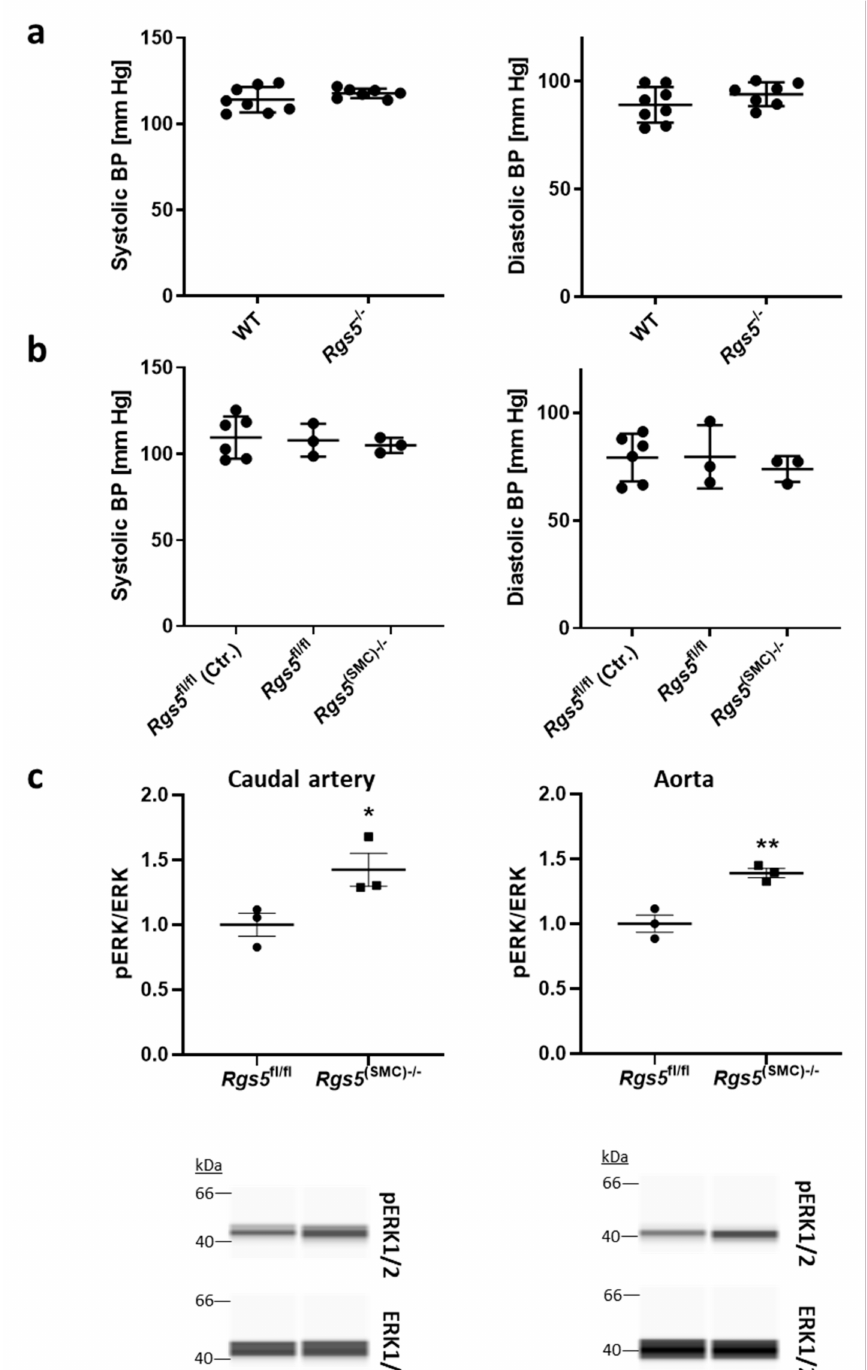
Figure 2. Telemetric assessment of the blood pressure and analysis of ERK1/2 phosphorylation in Rgs5 knockout mice. ( a ) The mean systolic and diastolic blood pressure were telemetrically recorded for 24 h in adult WT (n = 8) and Rgs5 − / − mice (n = 7). ( b ) Corresponding analyses were performed in SMMHC-CreER T2 - Rgs5 fl/fl mice before ( Rgs5 fl/fl Ctr., n = 6) and 8 days after injection of Miglyol ( Rgs5 fl/fl , n = 3) or tamoxifen ( Rgs5 (SMC) − / − , n = 3) to induce the SMC-specific knockout of Rgs5 . ( c ) Caudal arteries and aortas were collected from Rgs5 fl/fl and Rgs5 (SMC) − / − mice 3 weeks after induction of the knockout. pERK1/2 and total ERK1/2 abundance was quantified in tissue lysates by capillary electrophoresis/immunodetection-based techniques (* p < 0.05, ** p < 0.01, n =